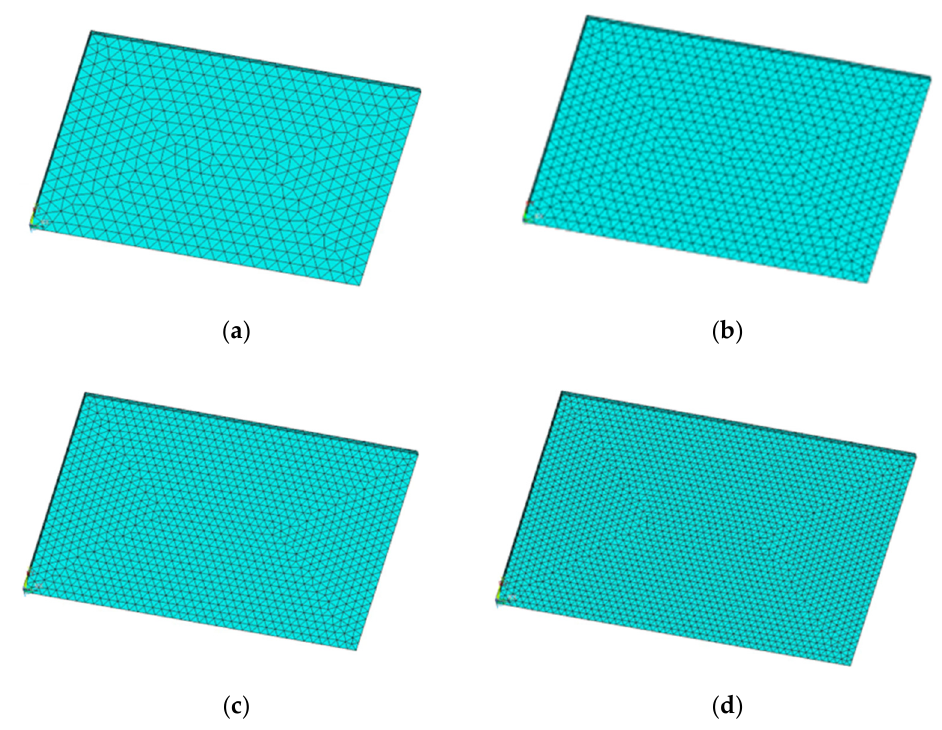
Figure 4. Finite element grid diagram. ( a ) Ne = 2868; ( b ) Ne = 4092; ( c ) Ne = 6523; ( d ) Ne = 11,616.